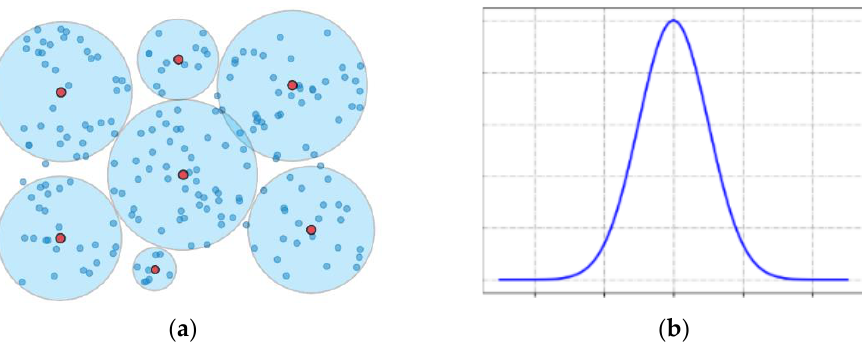
Figure 2. ( a ) Center of Gaussian kernel function and response radius to input data; ( b ) Gaussian kernel function.